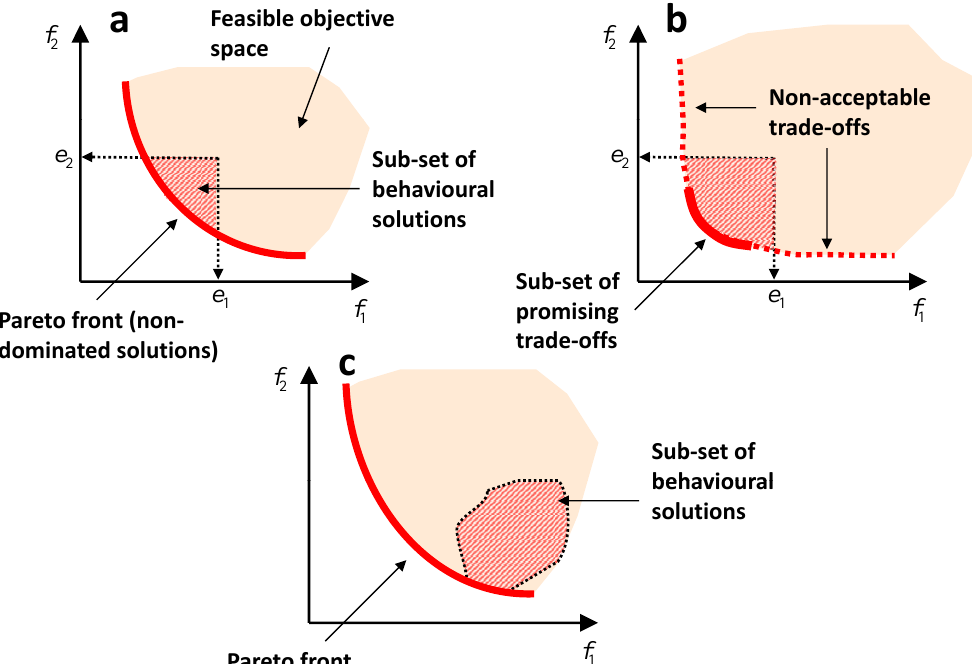
Fig. 10. Graphical examples illustrate Pareto optimal and behavioral solutions in the objective space for a two-dimensional ([ f 1 f 2 ]) multi- objective problem, with e =[ e 1 e 2 ] indicating limits of acceptability, i.e. cut-off thresholds for distinguishing behavioral and non-behavioral solutions for (a) smooth and (b) steep trade-off Pareto fronts. (c) The position of parameter sets identified by SuPer calibration (MDPF) in the objective space (After: Efstratiadis and Koutsoyiannis, 2010, with permission of the first author and the